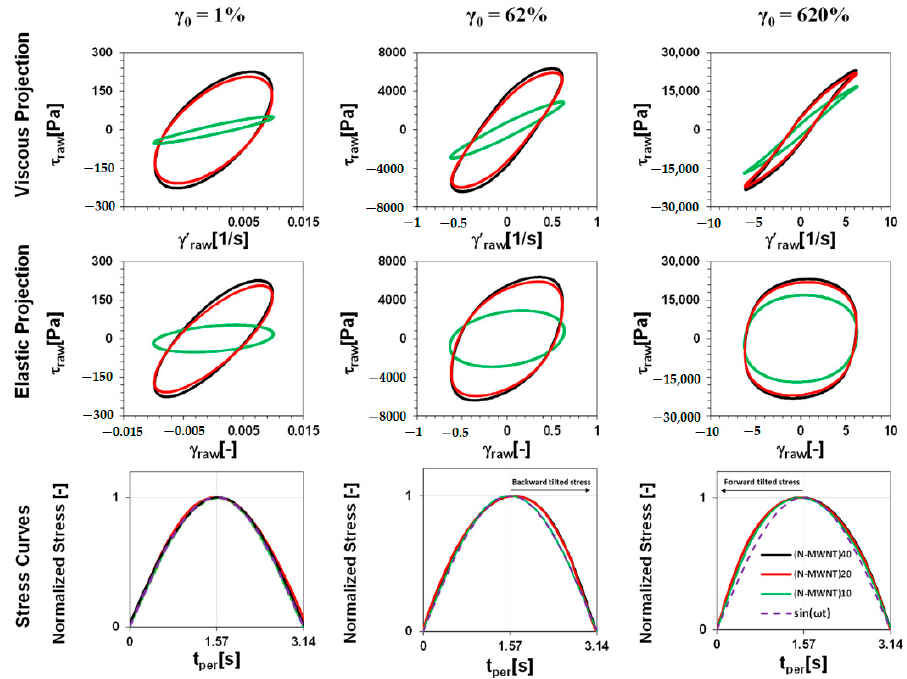
Figure 10. Lissajous–Bowditch loops of N-MWNTs/PVDF nanocomposites containing 2.0 wt.% of N-MWNTs synthesized at various Fe catalyst concentrations, 10 wt.% (green), 20 wt.% (red), and 40 wt.% (black) using parallel-plate geometry (gap size of 0.3 mm) at 210 °C. Elastic and viscous projections and stress curves are presented at strain amplitudes of 0 = 1.0, 62, and 620%, and an angular frequency of ω = 0.1 rad/s.